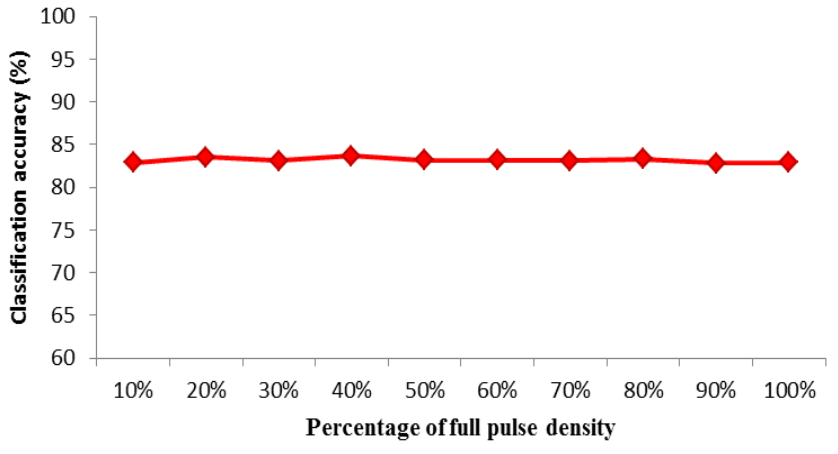
Figure 3. Overall classification accuracy for defoliation with different ALS pulse